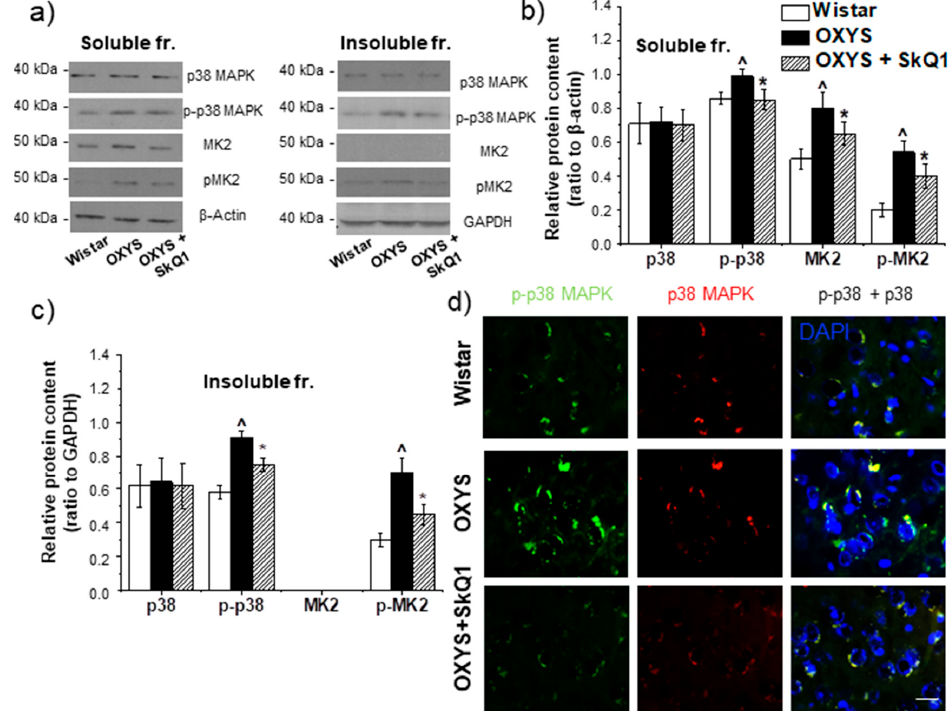
Figure 5. The impact of SkQ1 supplementation in OXYS rats from age 12 to 18 months on the amounts of proteins p38 MAPK, p-p38 MAPK, MK2, and p-MK2 in the hippocampus. Representative western blots of total and phosphorylated p38 MAPK and MK2 in the detergent-soluble and detergent-insoluble fractions in the hippocampus of untreated Wistar rats and OXYS, and OXYS rats with SkQ1 ( a ). Graphical presentation depicts relative protein content of p38 MAPK, p-p38 MAPK, MK2, and p-MK2 in the hippocampi of untreated Wistar and OXYS rats and in OXYS rats taking SkQ1 after normalization to β -actin for the detergent-soluble protein fraction ( b ) and normalization to GAPDH for the detergent-insoluble fraction ( c ). Data are presented as mean ± SEM of five independent experiments. Immunostaining of p38 MAPK and p-p38 MAPK ( d ) in the hippocampus of untreated Wistar and OXYS rats and OXYS rats taking SkQ1. The nuclei were stained with DAPI (blue). Scale bars, 25 μ m. ^ Statistically significant differences between the strains of the same age; * the effect of supplementation with SkQ1 ( p < 0.05).